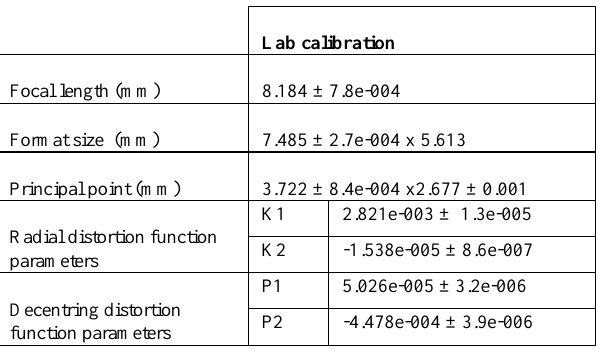
Table 1. Camera lab calibration parameter values